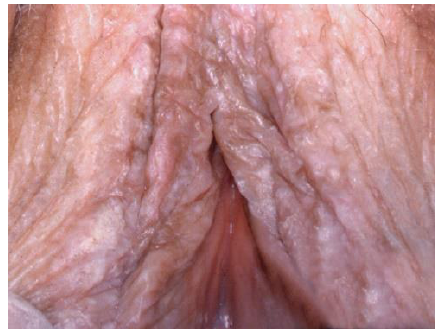
Figure 17. Lichenification.